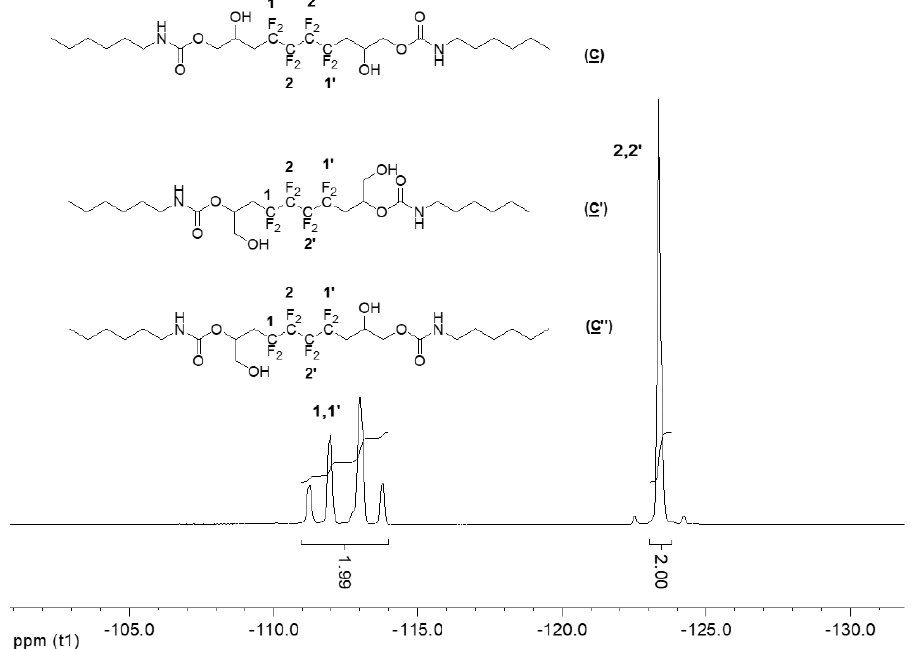
Figure 6. 19 F NMR spectrum of the model hydroxyurethanes ( C ), ( C′ ), and ( C″ ) (DMSO-d6, 20 °C, 235.2 MHz).